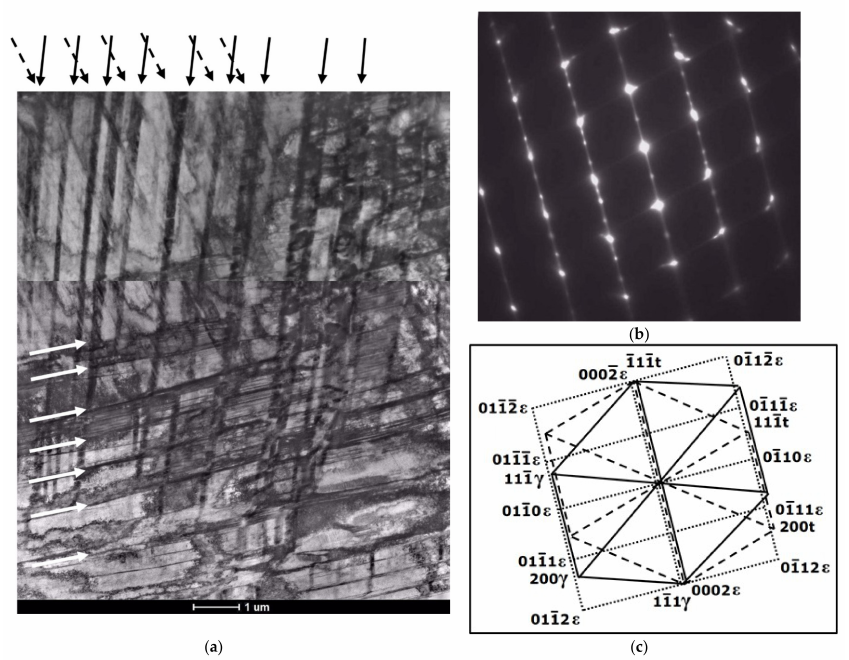
Figure 13. Bands from three deformation systems after 30% of deformation, bright image ( a ) and SAED pattern with schematic representation ( b , c ).